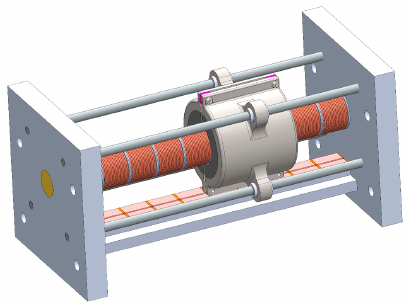
Figure 2. 3D geometrical structure of the CDCLM.